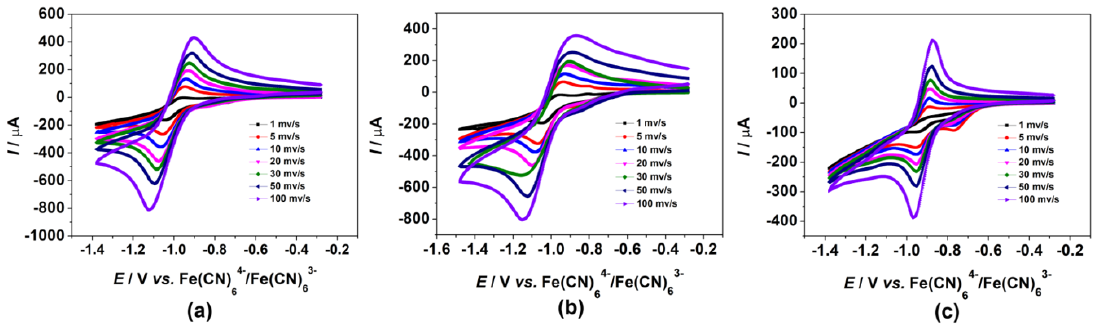
Figure 7. CVs of ARS ( a ), ARS+PSS ( b ) and ARS+BPEI ( c ) solutions in 0.1 M NaCl.